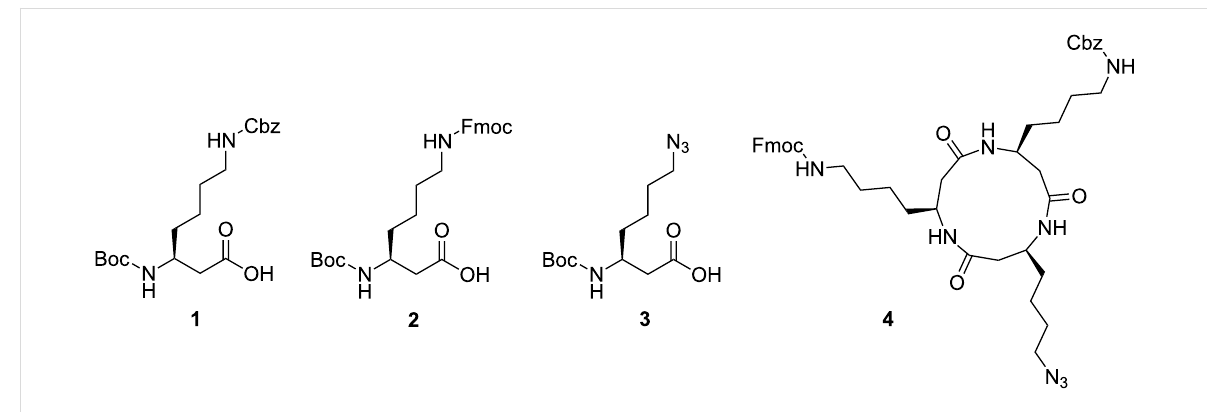
Figure 2: β -Amino acids 1 – 3 with orthogonal side-chain protection obtained by Arndt–Eistert homologation followed by Wolff rearrangement; cyclo- β - tripeptide template 4 as obtained by coupling of amino acids 1 – 3 followed by cyclization.